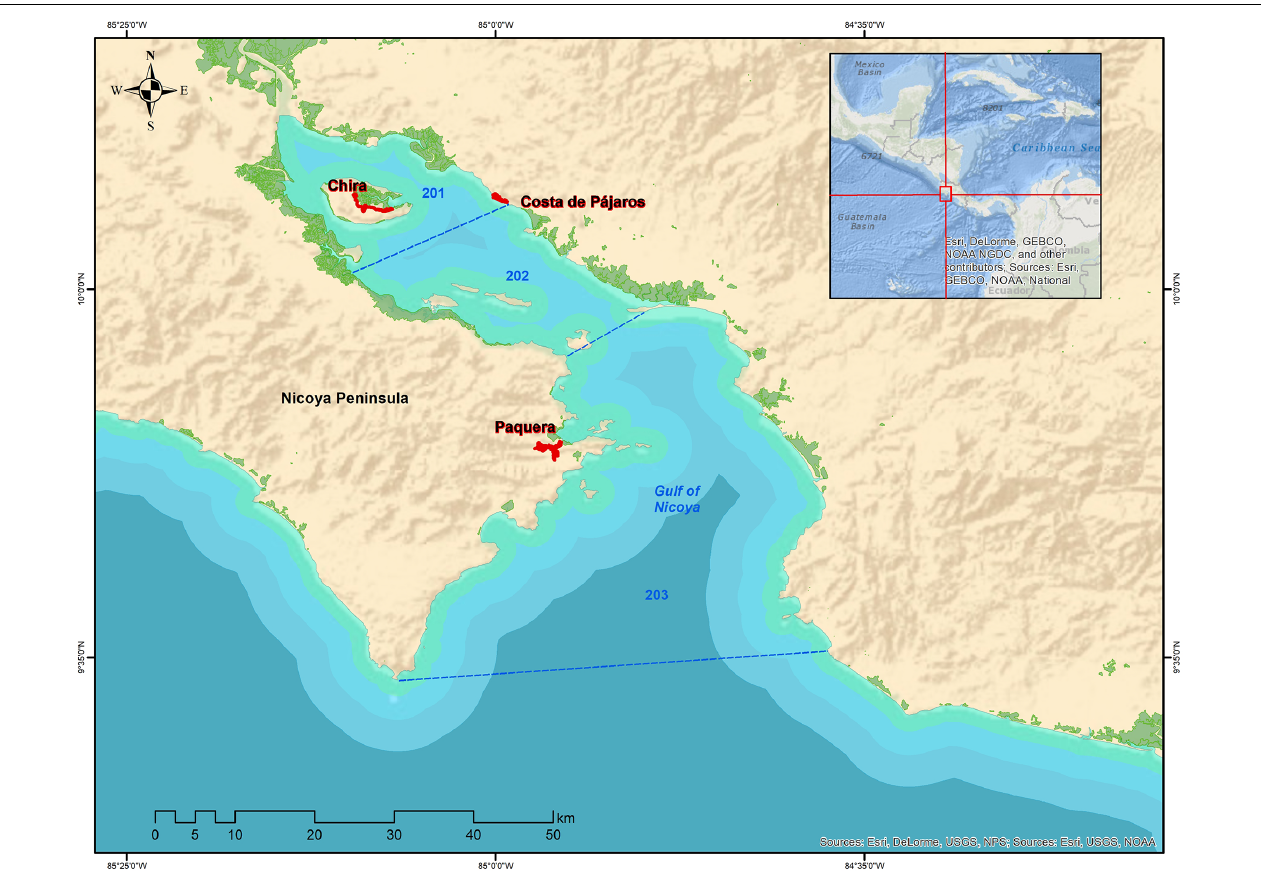
FIGURE 1 | Gulf of Nicoya (GoN) located on the Pacific coast of Costa Rica. The Gulf is sectored by Incopesca into areas 201, 202, and 203 based on species composition and fishing gears used (Marín-Alpízar and Vásquez, 2014). The three focal points selected for this study along the gulf were Isla Chira (inner area), Costa de Pájaros (inner-intermediate area), and Paquera-Tambor (outer